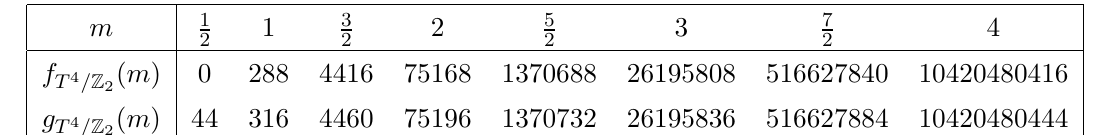
Table 1 . First few values of f